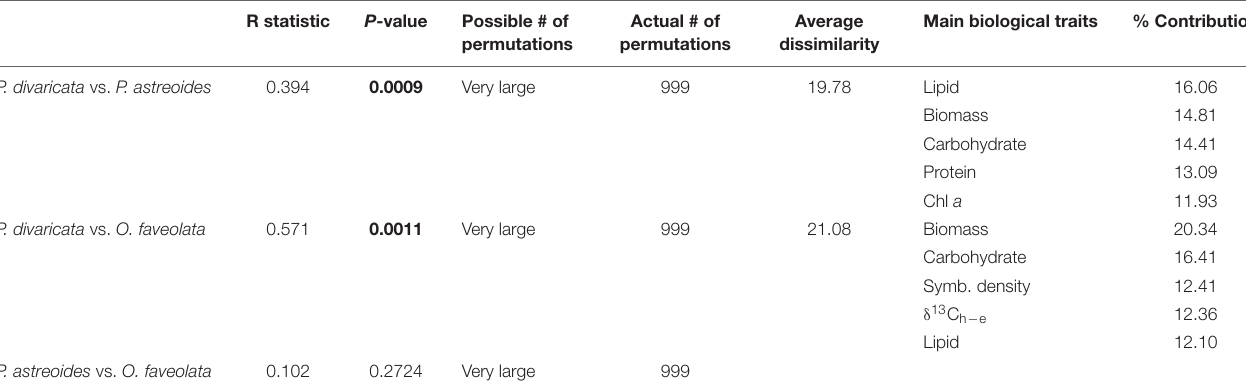
TABLE 1 | Results of pair-wise tests of the one-way analysis of similarity (ANOSIM) of the physiological profiles of Porites divaricata, Porites astreoides, and Orbicella faveolata (global R = 0.33, p = 0.001). R statistic P -value Possible # of Actual # of Average Main biological traits % Contribution permutations permutations dissimilarity